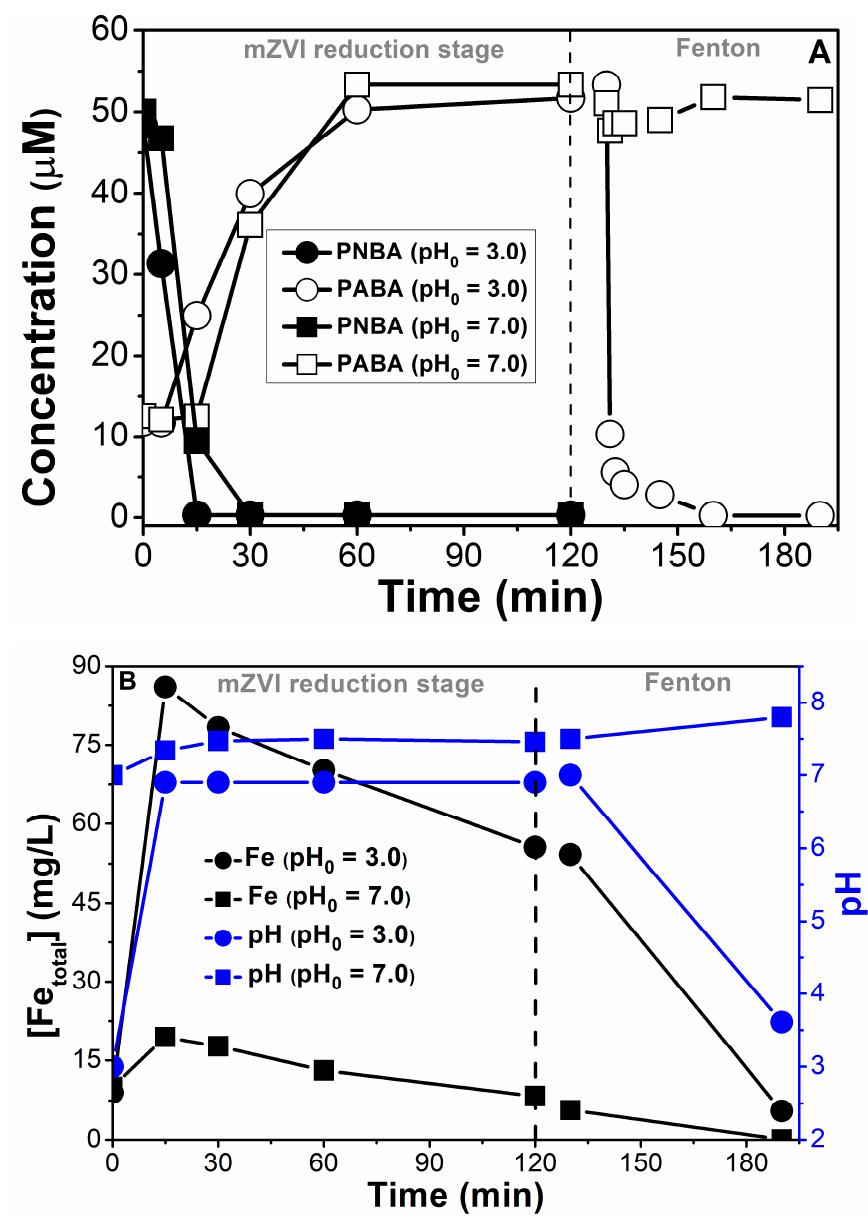
Figure 6. mZVI reuse for new PNBA 60 µM solutions prepared in NW with initial pH 3.0 and 7.0. 10 min for mZVI separation previous H 2 O 2 50 mg/L addition in the subsequent Fenton step: ( A ) PNBA decay and PABA formation; ( B ) total dissolved iron and pH are also shown .